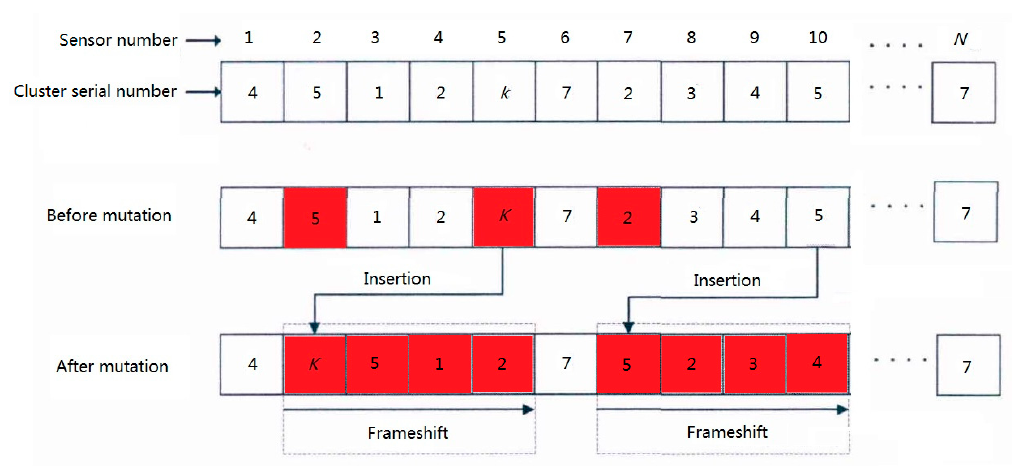
Figure 5. Chromosome mutation process.